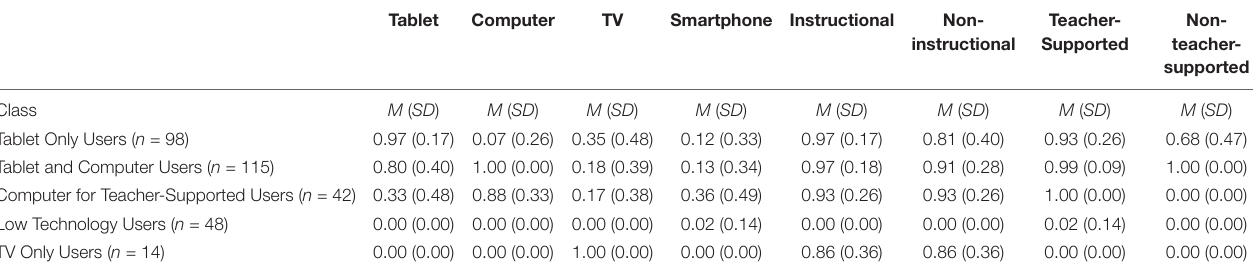
TABLE 5 | Descriptive statistics for device use, context, and purpose by